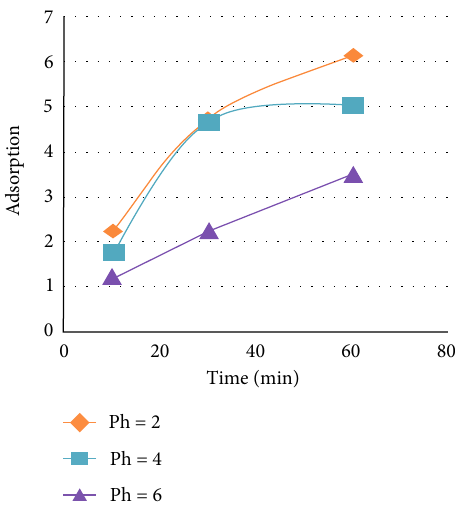
Figure 7: The relationship of time to adsorption for di ff erent values of the acidity function at a concentration of 30ppm.